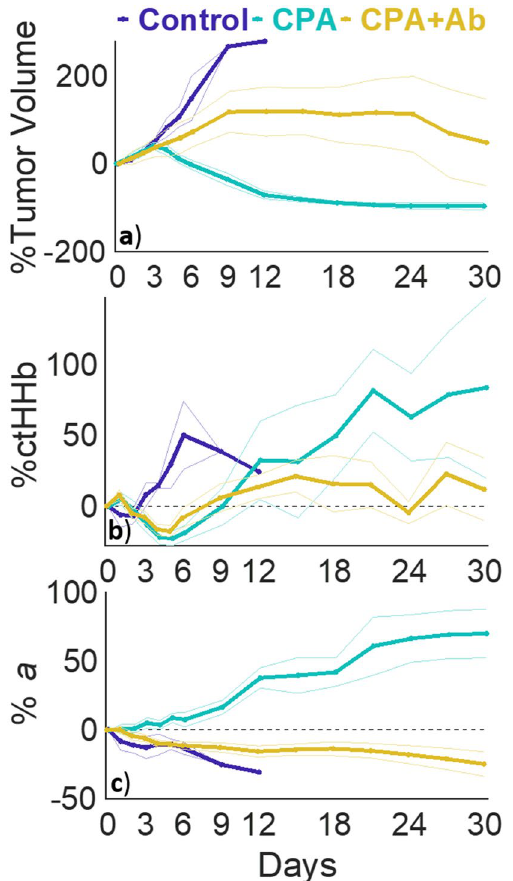
Figure 2. Longitudinal day 30 volume and optical changes across treatment groups. Percent change in ( a ) tumor volume, ( b ) ctHHb, ( c ) a separated by treatment: Control (purple), CPA (blue), CPA + Antibody (yellow). Lines represent means and shaded bars represent standard